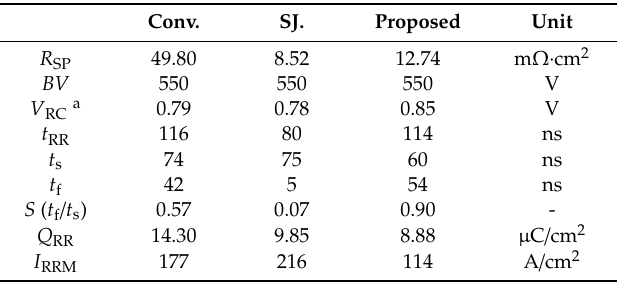
Table 2. Comparison of the device characteristics.